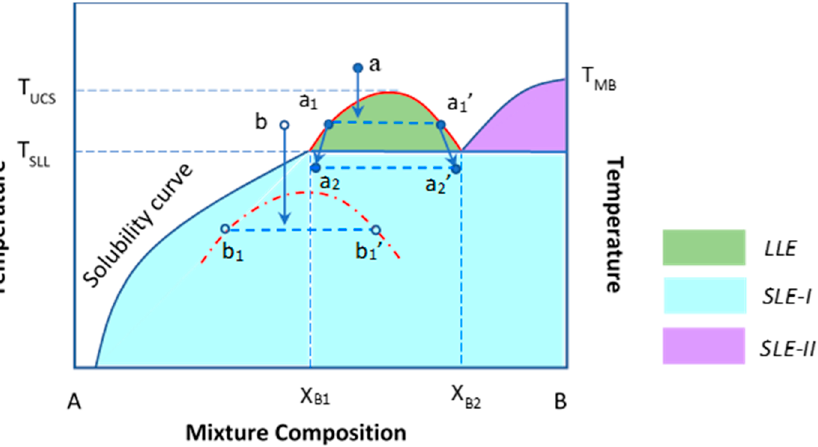
Figure 1. Polythermal diagram of a binary mixture of Components A (solvent) and B (solute). The melting point of Component B is T MB .